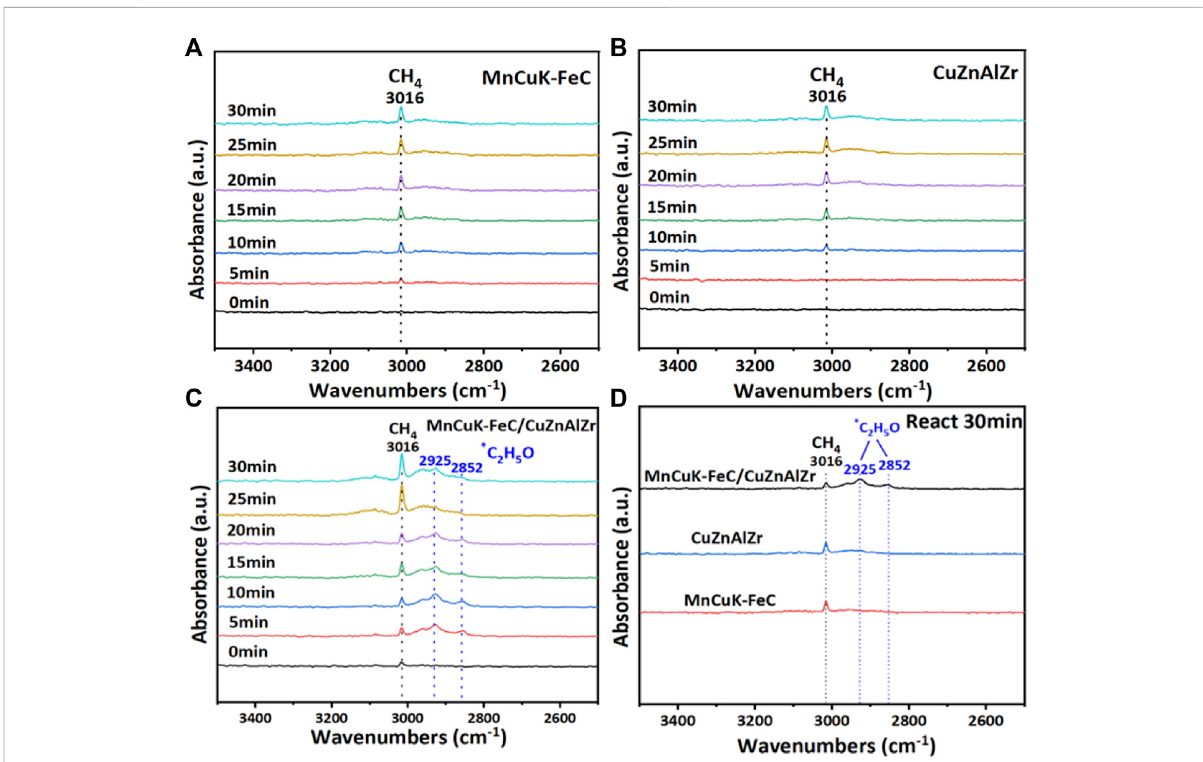
FIGURE 6 In-situ DRIFTspectraofCO 2 +H 2 reaction over (A) MnCuK-FeC. (B) CuZnAlZr. (C) MnCuK-FeC/CuZnAlZr. (D) Comparison ofthethreecatalysts after 30min reaction. (Reaction conditions: 15.0 ml/min H 2 +5.0 ml/min CO 2 , 1.0 MPa, 300 °